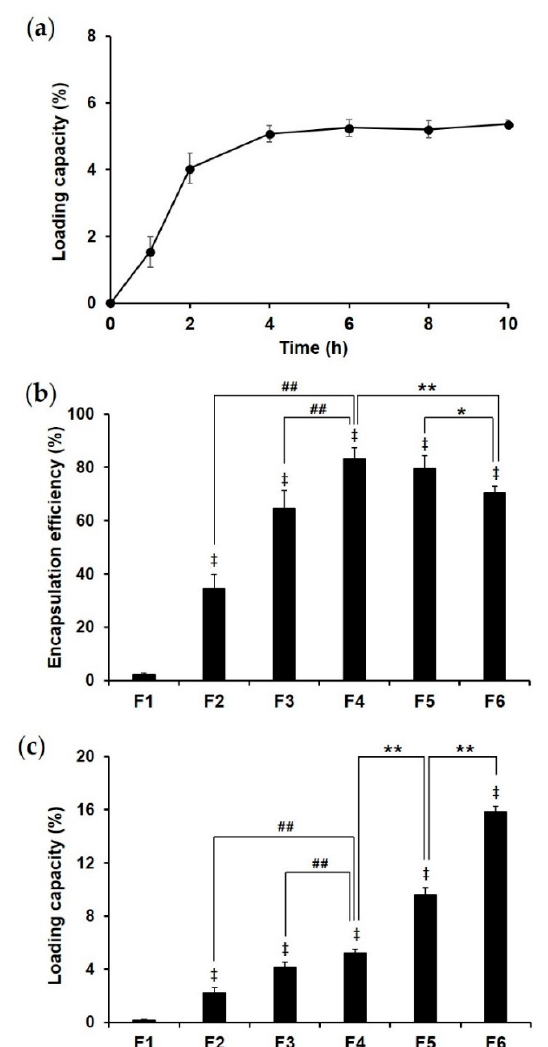
Figure 2. ( a ) Loading capacity (%) in porous PLGA MS (F4) as a function of time (hours). Drug loading capacity (%) reached equilibrium at 6 h. ( b ) Encapsulation efficiency and ( c ) loading capacity of formulations F1–F6. The values are expressed as mean ± SD ( n = 3). ‡ p < 0.01 compared to F1, ## p < 0.01 compared to F4, * p < 0.05 compared to F6, ** p < 0.01 compared to F6. PLGA, poly(lactide- co -